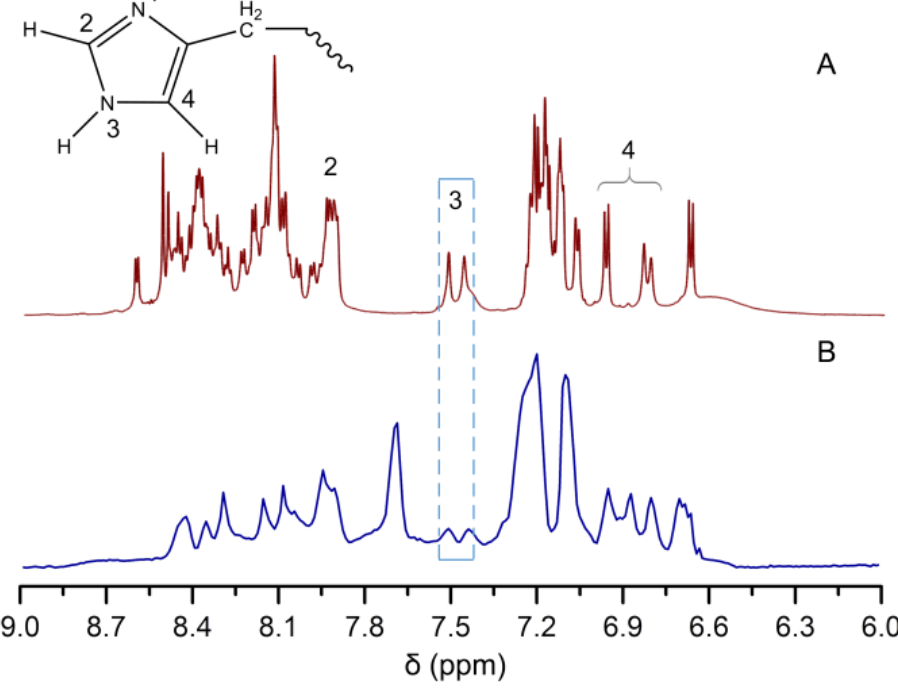
Figure 8. 1 H-NMR spectra of A β 40 (200 μ M) in the absence ( A ) and presence ( B ) of MnPM (200 μ M) after incubation at 37 °C and pH 7.4 for 24 h.